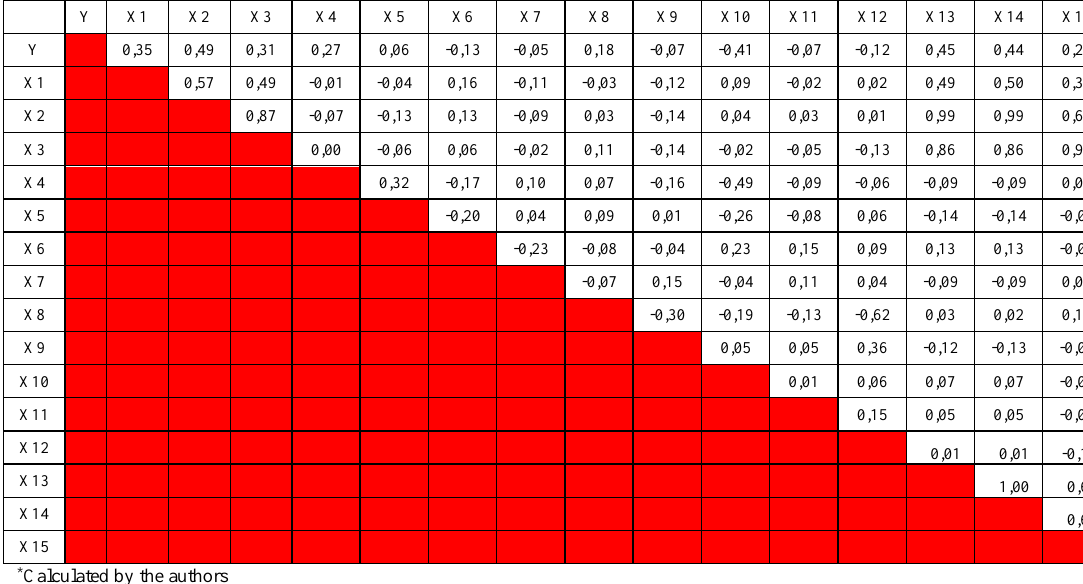
Table 4. Determination of various combinations of pair correlation coefficients (R) along the main diagonal *